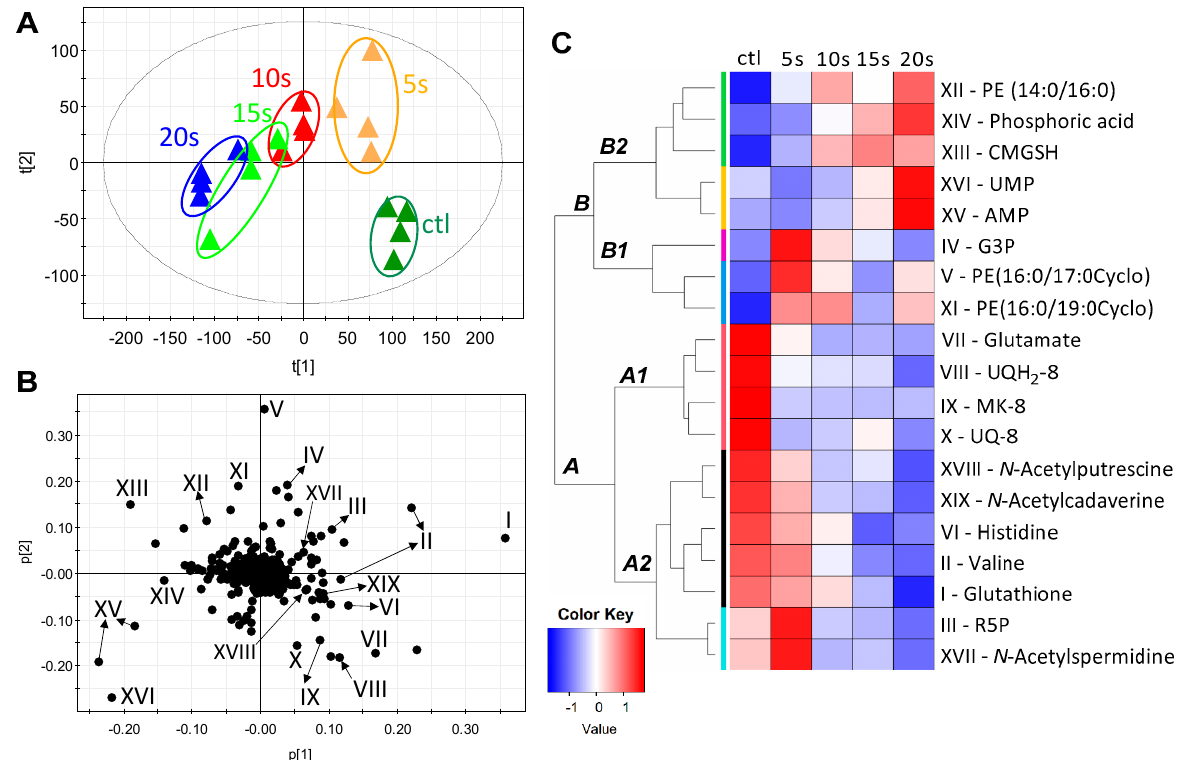
Figure 2. Modeling of IPL-elicited changes in the E. coli metabolome. Pooled data from the LC-MS analysis of organic and aqueous extracts of E. coli cells were processed by principal components analysis (PCA). ( A ) Scores plot of the PCA model. The samples in the same treatment group ( n = 4) are circled. A scores plot containing three quality control (QC) samples is presented in Figure S2. ( B ) Loadings plot of the PCA model. The labeled markers (I–XIX) are the identified metabolites that contribute to the separation of sample groups. Their identities are listed in Table 1. ( C ) Heatmap from the clustering analysis of IPL-responsive markers (I–XIX). PE, phosphatidylethanolamine; CMGSH, S -carboxymethyl-glutathione; UMP, uridine monophosphate; AMP, adenosine monophosphate; G3P, glycerol 3-phosphate; UQH 2 -8, ubiquinol-8; MK-8, menaquinone-8; UQ-8, ubiquinone-8; R5P, ribose 5-phosphate. Table 1. Detection and identities of IPL-responsive metabolites in the E. coli metabolome. The metabolite markers were detected in four different modes, including positive-mode detection of protonated metabolites ([M + H] + ) in aqueous ex- tracts, negative-mode detection of deprotonated metabolites ([M − H] − ) in aqueous extracts, positive-model detection of dansylated metabolites ([M + DC] + ) in aqueous extracts, and positive-mode detection of both protonated ([M + H] + ) and ammonium ([M + NH 4 ] + ) adducts in lipid extracts.